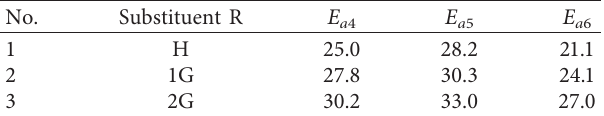
Figure 6: Energy barrier of ring opening step in relation to the substituent R which owns the -I effect in R-CH Table 2: The calculational data of rate constants and mole percent ratio at 120 ° C. Reactions